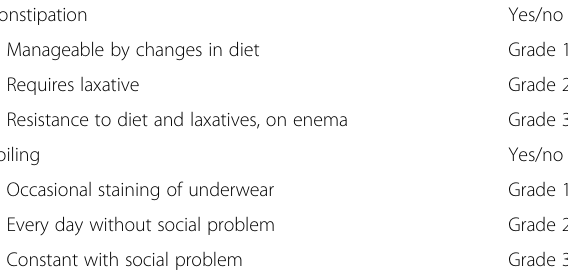
Table 1 Assessment and grading of constipation and soiling using Krickenbeck classification in patients with recto-perineal fistula before and after the repair